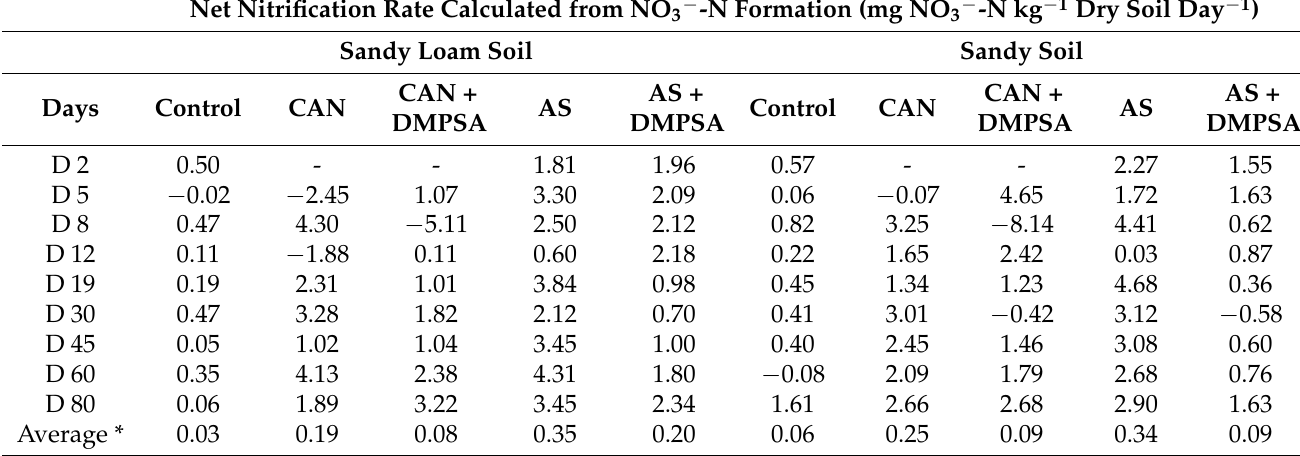
* Average daily soil nitrification rate during the periods between sampling. Within a column, values indicate the average soil nitrification rate (mg